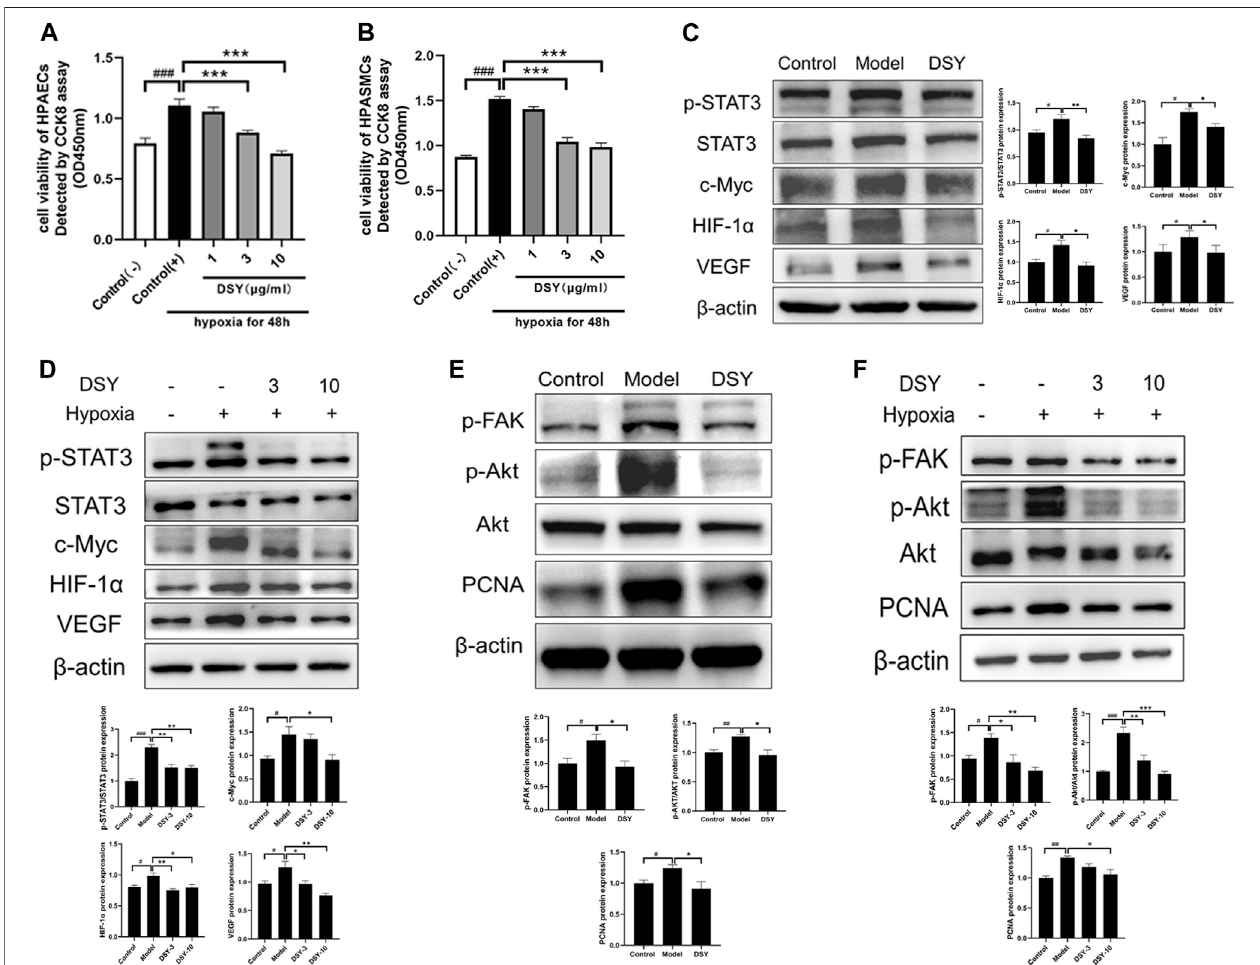
FIGURE 6 | (A) Cell viability of HPAECs after incubating in hypoxia environment for 48 h detected by CCK8 assay. (B) Cell viability of HPASMCs after incubating in hypoxia environment for 48 h detected by CCK8 assay. (C) Effect of DSY on STAT3-HIF-VEGF in vivo . (D) Effect of DSY on STAT3-HIF-VEGF in HAPECs. (E) Effect of DSY on FAK-AKT in vivo . (F) EffectofDSY on FAK-AKT inHPASMCs.The dataareexpressed asthe mean±SEM ( n =3 – 5). # p < 0.05vs. control group. ## p < 0.01vs. control group. ### p < 0.001 vs. control group. * p < 0.05 vs. model group. ** p < 0.01 vs. model group. *** p < 0.001 vs. model group.